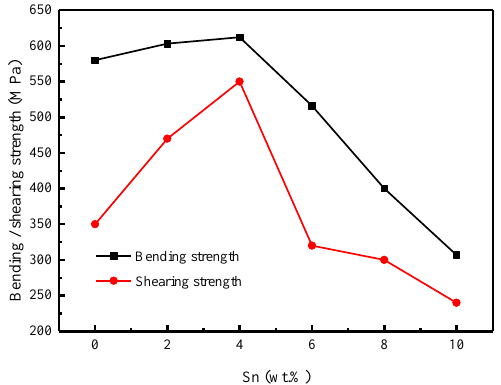
Figure 7. Bending strength of matrix of sintered samples with different Sn contents.